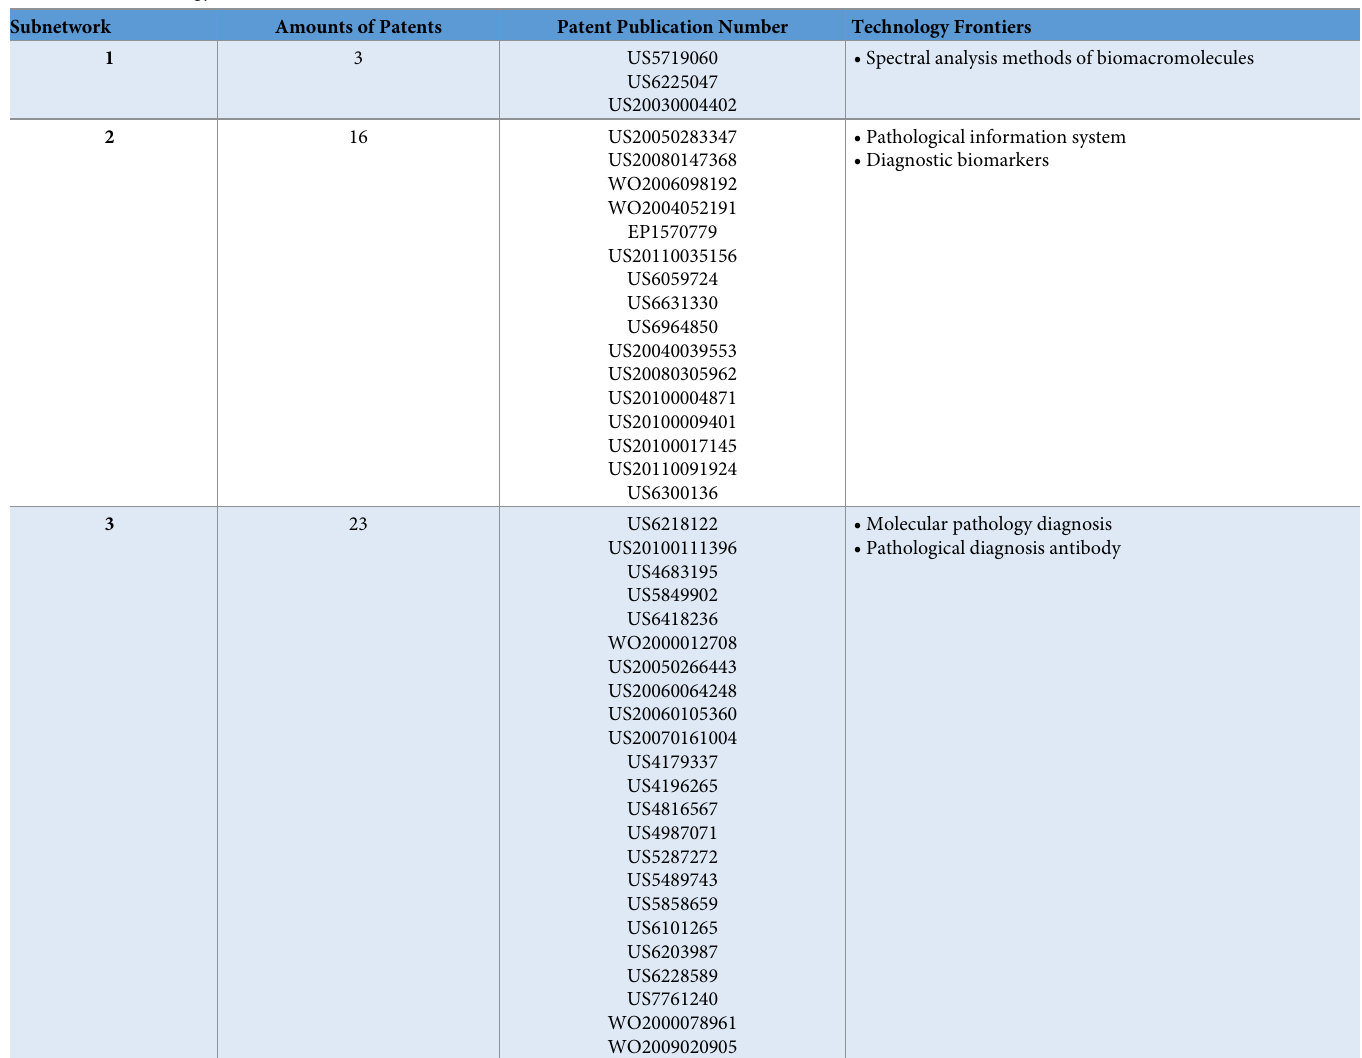
Table 2. The technology frontiers from 2001 to